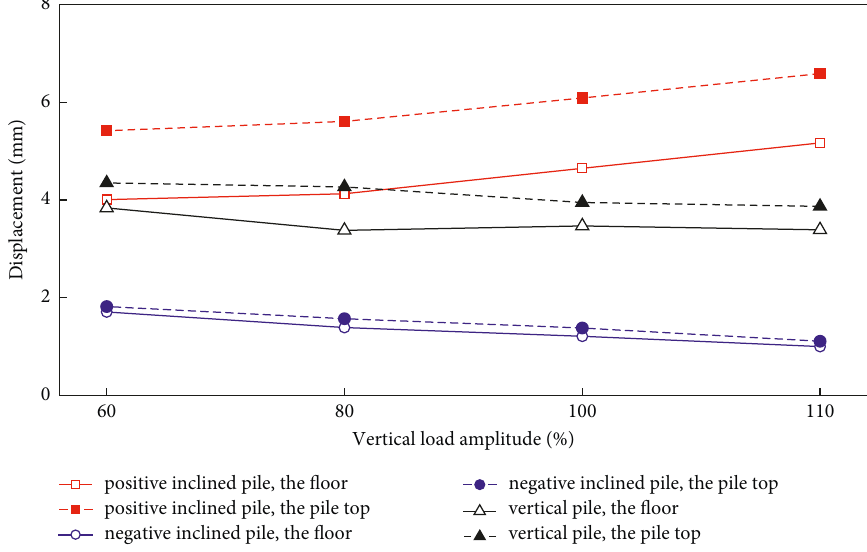
Figure 8: Pile displacement line